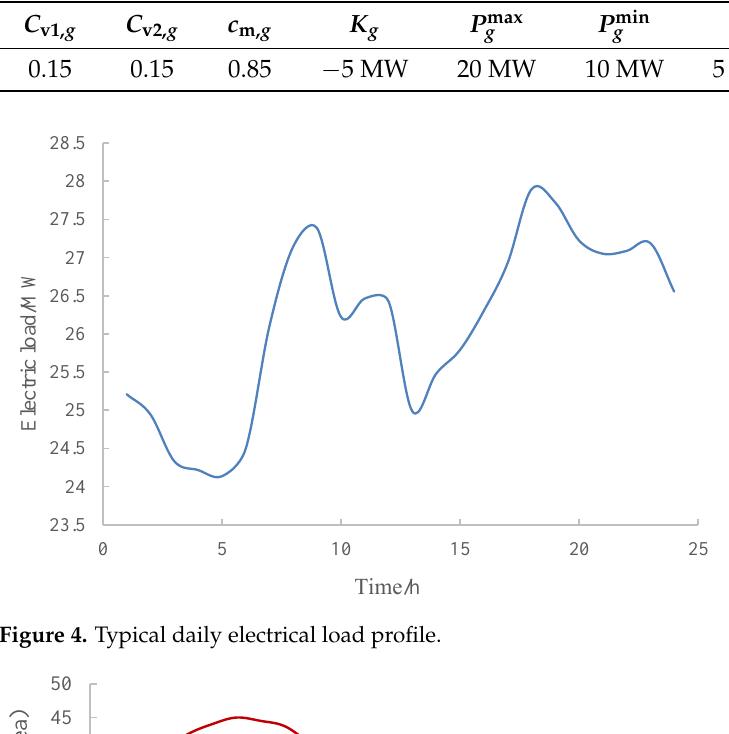
Table 2. Technical parameters of CHP units.